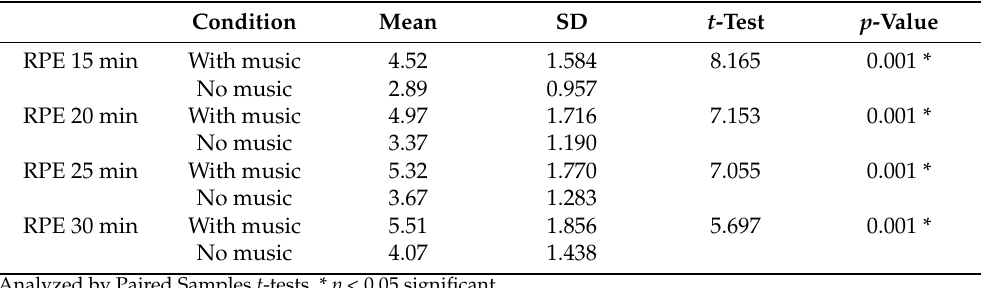
10 of 18 Table 4. Table with and without music for RPE differences (Unit: level). Condition